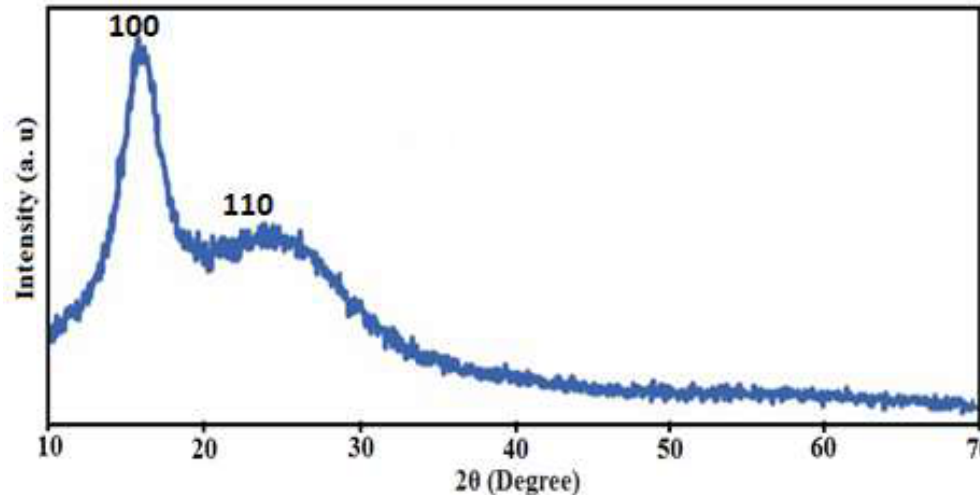
Figure 7: XRD pattern of PAN nanofibers at concentration of 15